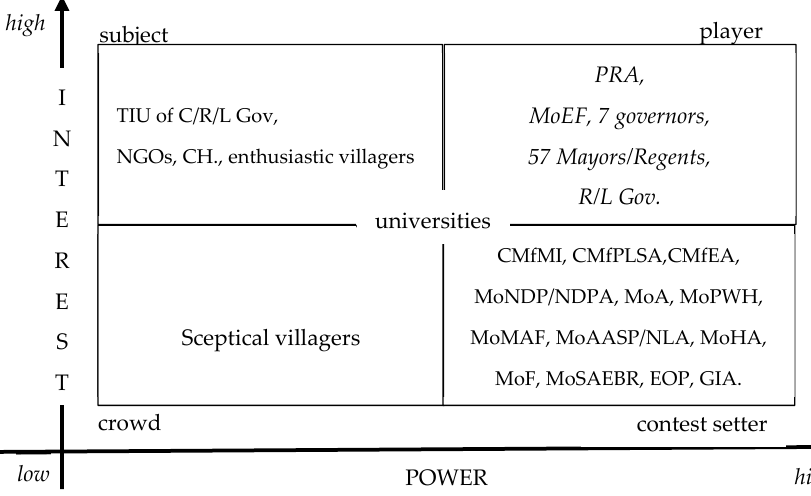
Figure 3. Power–interest matrix of stakeholder analysis of the acceleration of peat restoration in Indonesia. Description: PRA (The Peatlandt Restoration Agency); MoEF (Ministry of Environment and Forestry); R/L Gov (Regional/Local Government); CMfMI (Coordinating Ministry for Maritime and Investment Affairs); CMfPLSA (Coordinating Ministry for Politics Law and Security Affairs); CMfEA (Coordinating Ministry for Economy Affairs); MoNDP/NDPA (Ministry of National Development Planning/National Development Planning Agency); MoA (Ministry of Agriculture); MoPWH (Ministry of Public Works and Public Housing); MoMAF (Ministry of Marine Affairs and Fisheries); MoAASP/NLA (Ministry of Agrarian Affairs and Spatial Planning/National Land Agency); MoHA (Ministry of Home Affairs); MoF (Ministry of Finance); (MoSAEBR (Ministry of